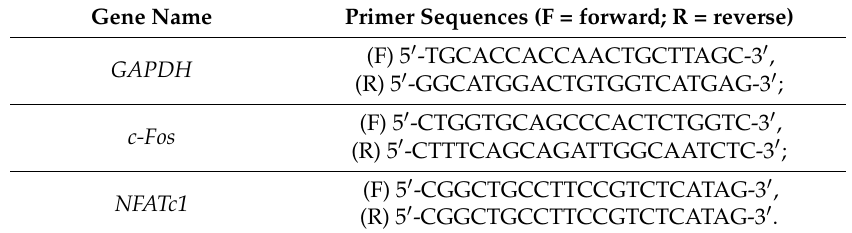
Table 1. Genes and primer sequences used in reverse transcriptase-polymerase chain reaction (RT-PCR). Gene